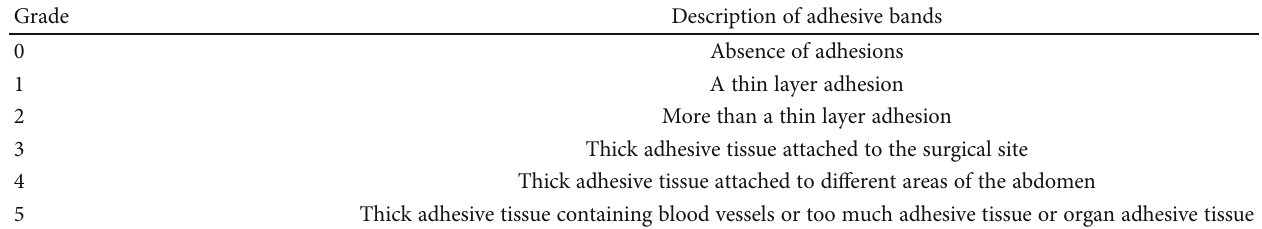
Table 2: Scoring system for peritoneal adhesion according to Adhesion Scoring Scheme [44,